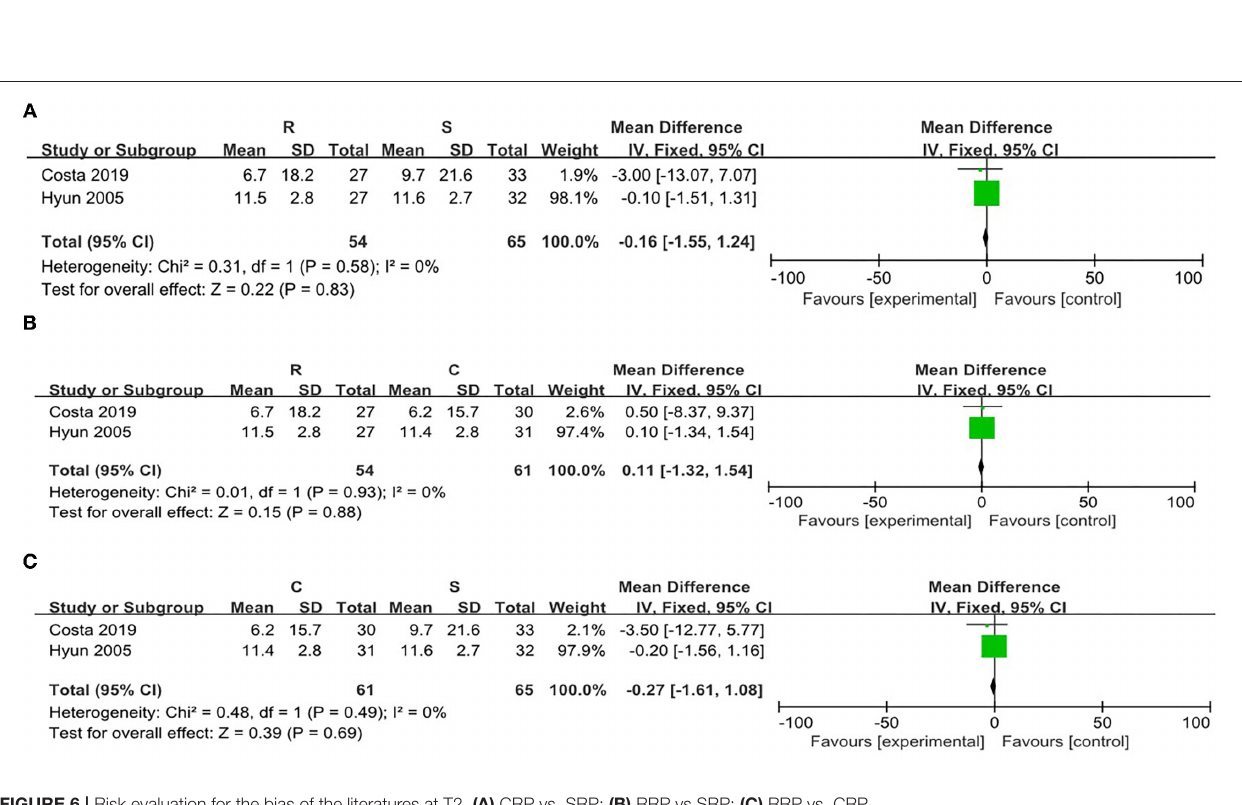
Frontiers in Surgery |